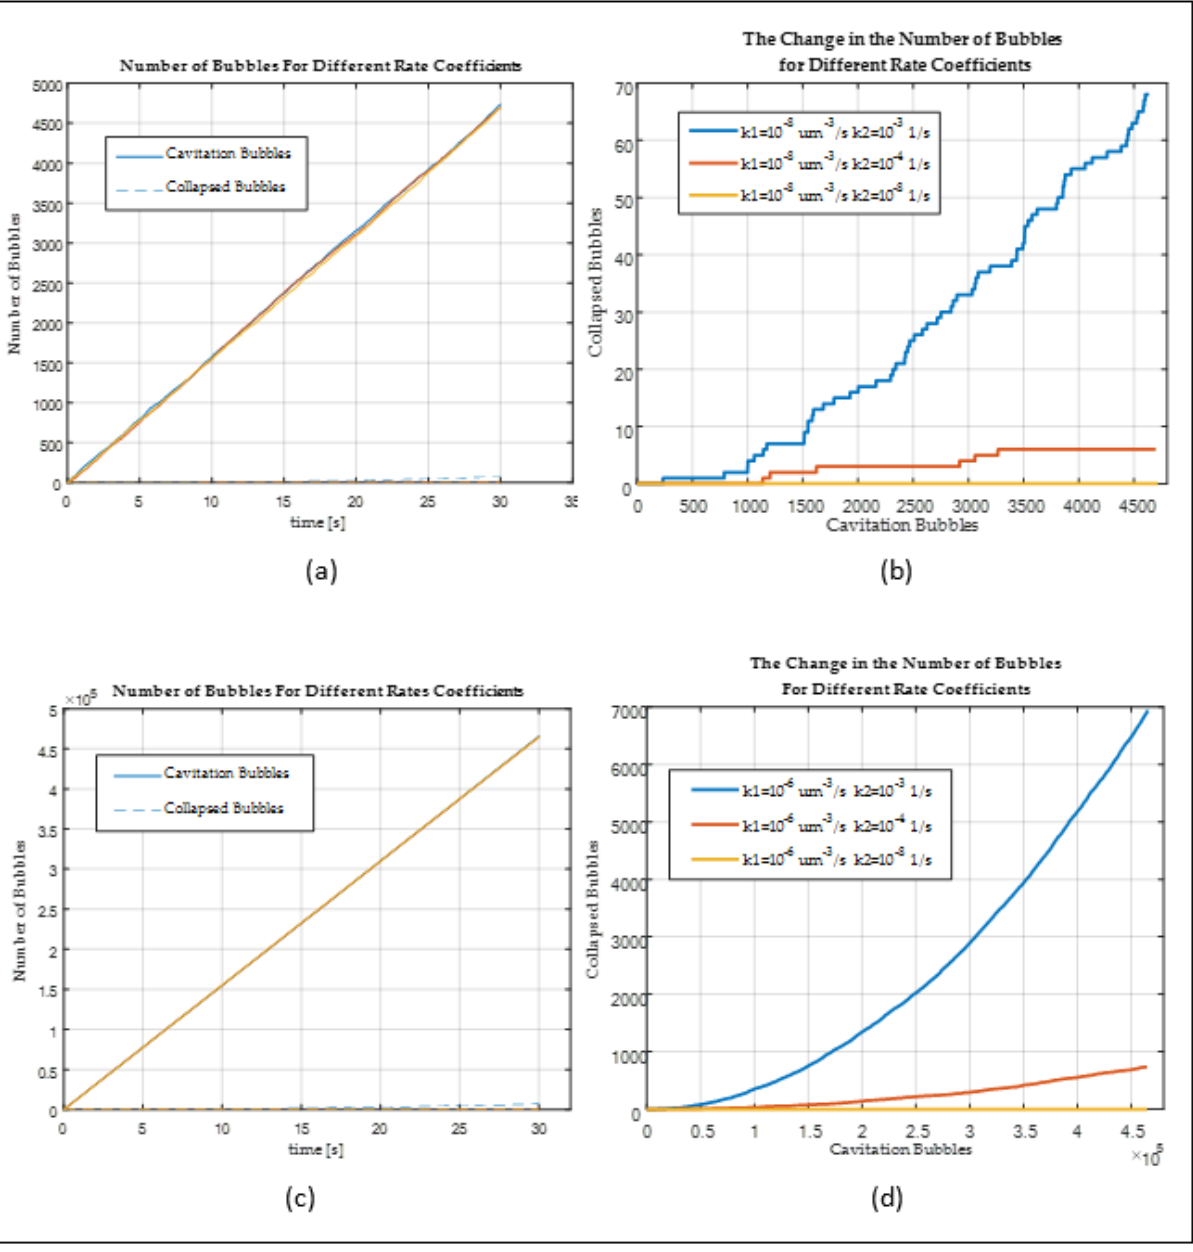
Figure 7. Simulation 3 — changes in the constants and coefficients. ( a ) Number of bubbles for k1 = 10 − 8 µ m − 3 /s and different values of k2. ( b ) Cavitation and collapsed bubbles for k1 = 10 − 8 µ m − 3 /s and different values of k2. ( c ) Number of bubbles for k1 = 10 − 6 µ m − 3 /s and different values of k2. ( d ) Cavitation and collapsed bubbles for k1 = 10 − 6 µ m − 3 /s and different values of k2.